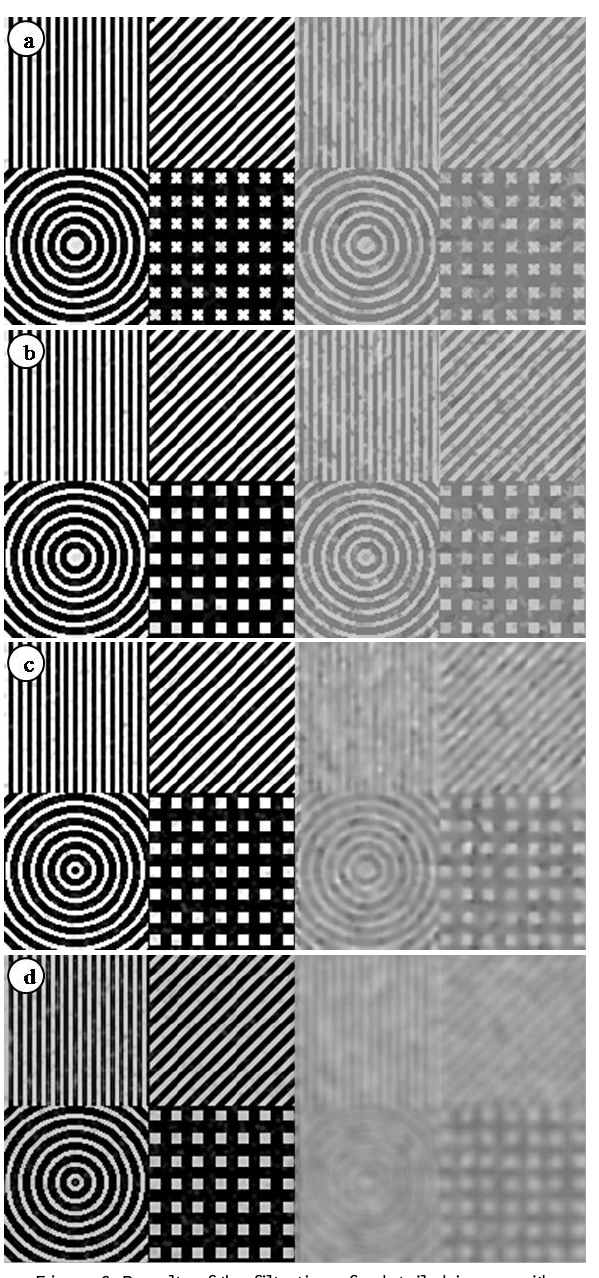
Figure 6. Results of the filtration of a detailed image with simulated speckle, using: a) MSE filter, b) MSE filter by speckle suppression properties. The water surface is more reconstruction, c) Frost, d) Gamma-MAP filter; filter window homogenous after filtration with the use of these filters. The (SE) size: 4 differences between other filters are relatively small, but a higher “smoothness” of the MSE filter (Figure 7g) can be noticed, confirming good efficacy of this filter in this